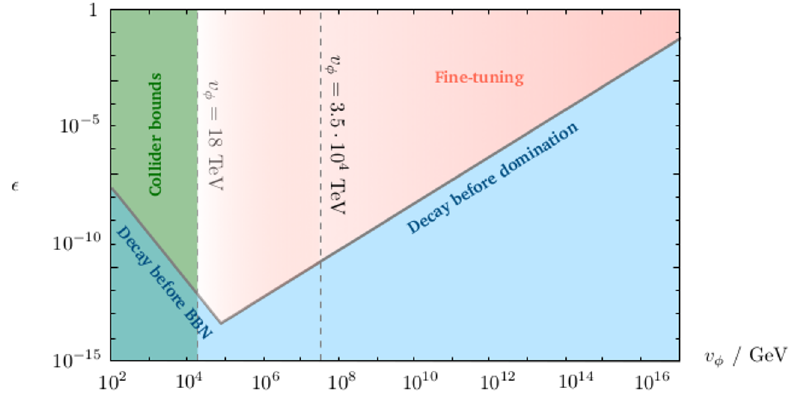
Figure 4 . Constraints on the size of the coefficient of the Planck-suppressed HDO of eq. (5.16), as a function of the scale of spontaneous symmetry breaking, v φ . The region v φ . 18 TeV (green) is in conflict with direct bounds on the mass of W 0 and Z 0 resonances, under the assumption that v φ ∼ v 0 , as discussed in section 3.1. Values of (cid:15) that are too small (blue) do not destabilize the domain wall network early enough to either avoid a domain-wall-dominated era, or to ensure collapse before the onset of BBN, and are therefore ruled out. The region of parameter space in pink is experimentally allowed, but the level of fine-tuning in the electroweak sector worsens as v φ is increased (corresponding to a darker shade). The dashed line at v φ ’ 3 . 5 · 10 4 TeV corresponds to a fine-tuning of O (10 − 10 ) in the electroweak sector. (For illustration, we have set the quartic coupling in the pseudo-scalar potential to be κ φ = 1 in this